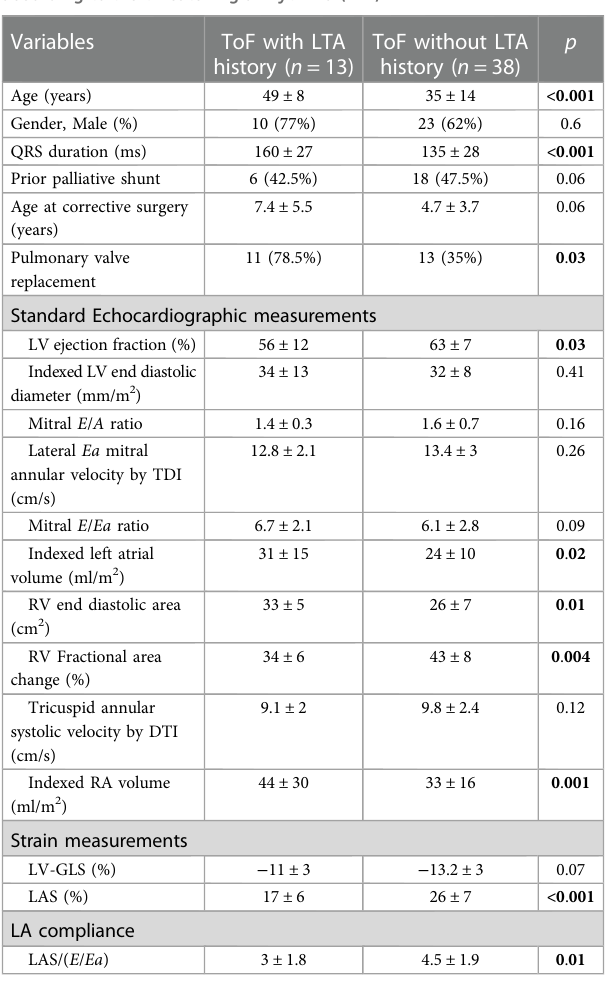
TABLE 3 Characteristics of patients with repaired Tetralogy of Fallot (ToF) according to life threatening arrhythmia